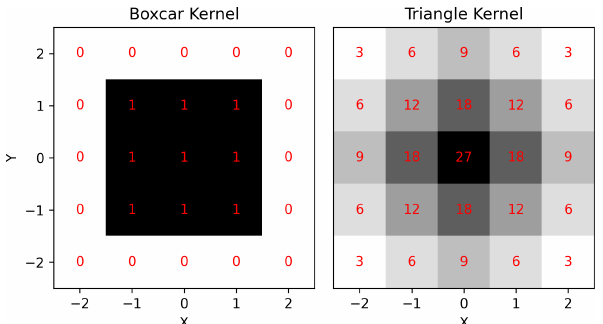
Figure 5. Graphical representation of the boxcar and the triangle kernels. The 2D slices are taken from the middle of the kernel’s third dimension. For better clarity, the boxcar kernel is padded with zeros and the kernel weights, shown in red font, are not normalized.